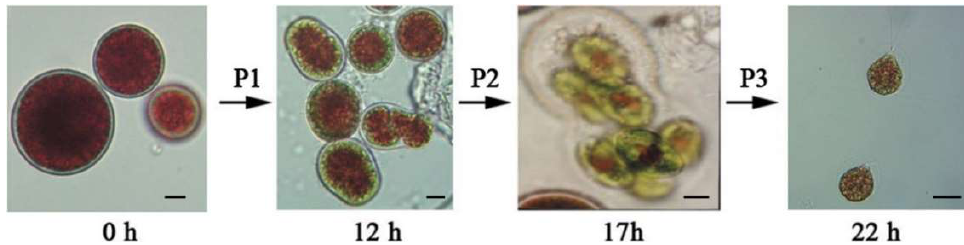
Figure 1. Light microscopic images of four sampling points during H. pluvialis non-motile cell germination. 0 h, non-motile cells; 12 h, repeated mitotic events within the mother non-motile cell; 17 h, cytokinesis to form the zoospores within the mother non-motile cell; 22 h, cell wall of the mother non-motile cell ruptures and the new motile cells are released. P1, P2, and P3 are short for phase I, phase II, and phase III, respectively. The length of each bar represents 10 µm.